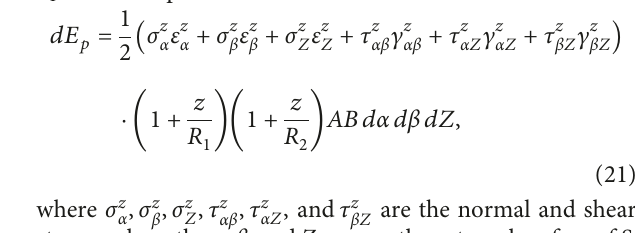
Figure 16: Schematic of energy feature parameters.